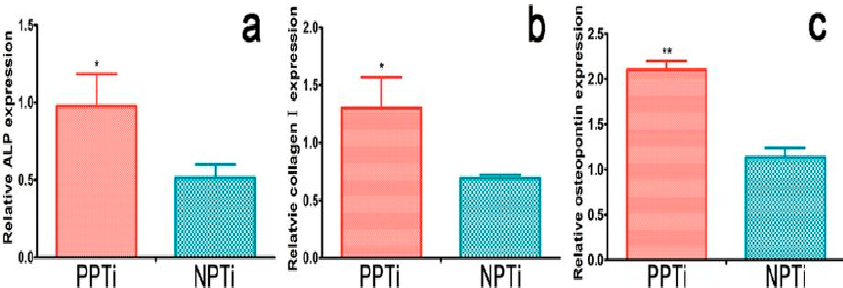
Figure 20. ( a ) Relative ALP, ( b ) collagen I, and ( c ) osteopontin gene expressions of rBMSCs cultured on PPTi and NPTi samples for 14 days ( n = 3). * p < 0.05, ** p < 0.01 compared with NPTi.